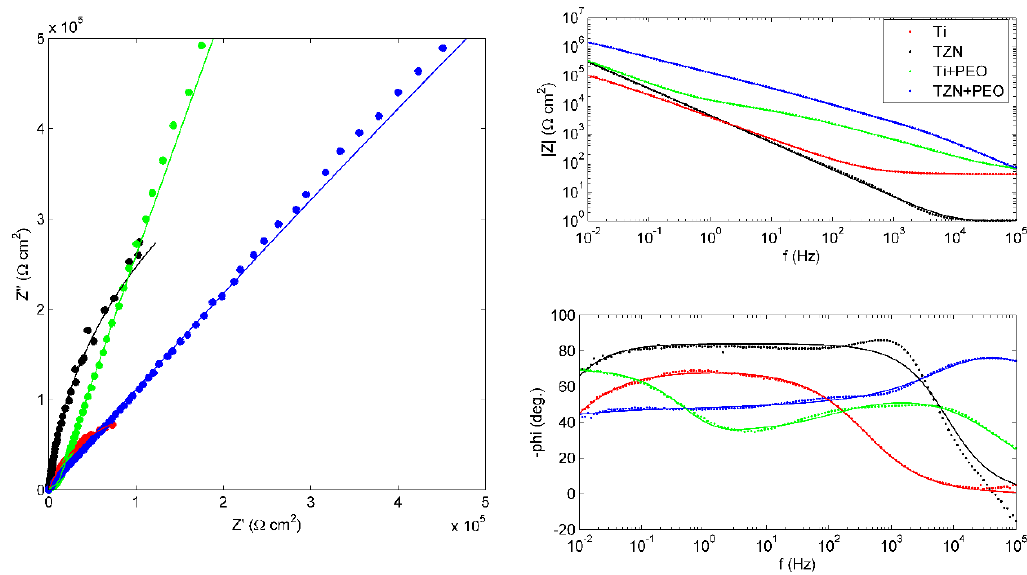
Figure 6. Nyquist and Bode plots for the uncoated and PEO coated Ti and TZN samples.